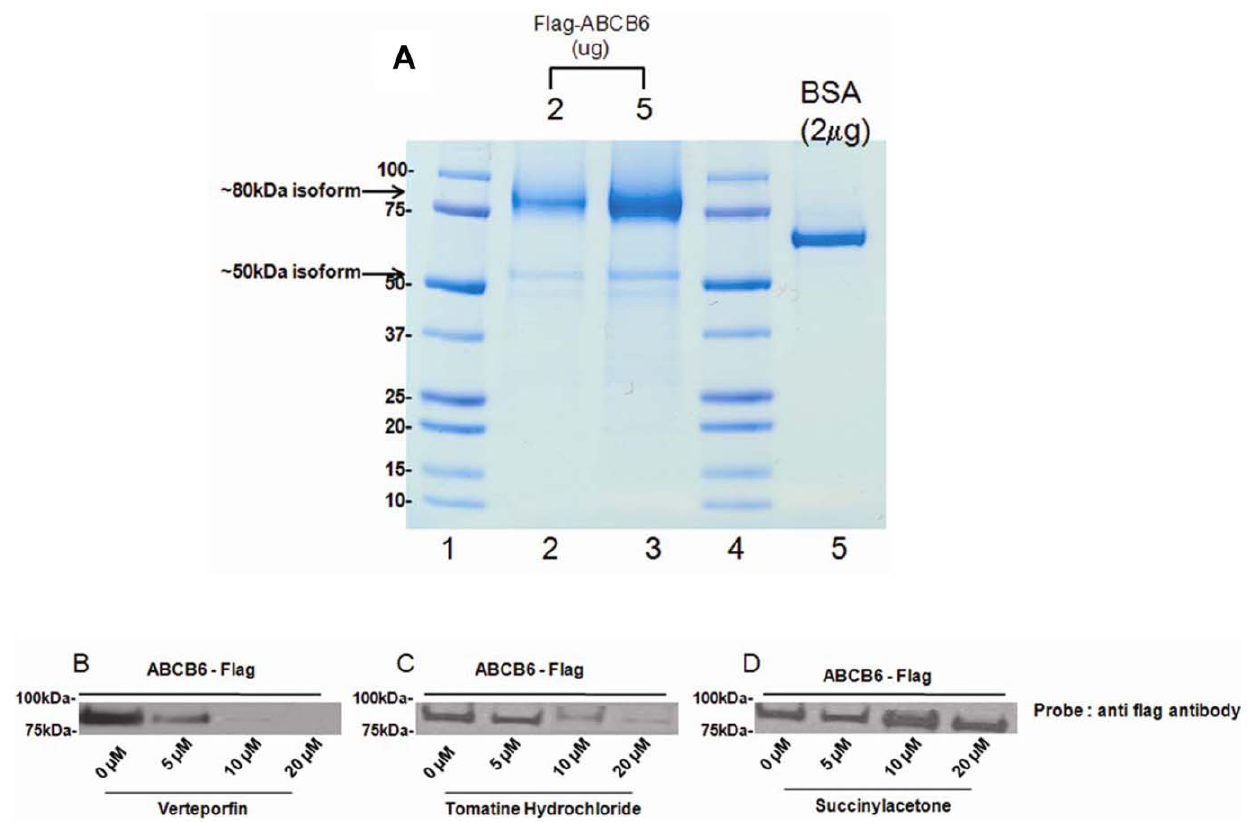
Figure 6. SDS-PAGE analysis of purified ABCB6 and selectivity and validation of HTS identified compounds by hemin-agarose affinity chromatography using purified ABCB6. (a) Purified ABCB6 sample was analyzed by SDS-PAGE. The figure shows coomassie brilliant blue staining of SDS gel (lane legends are 1, protein marker; 2, purified ABCB6-flag 2 m g protein; 3, purified ABCB6-flag 5 m g protein; 4, protein marker; and 5, bovine serum albumin control). b) verteporfin and (c) tomatine hydrochloride potently disrupt the interaction between purified ABCB6 protein and hemin-agarose compared with (d) succinylacetone. Three hundred nanograms of purified ABCB6-flag protein was incubated in the presence or absence of increasing concentration of the indicated compound and hemin-agarose and the resulting complex was immunoblotted using a monoclonal antibody to the flag-tag. Results are representative of three independent experiments.